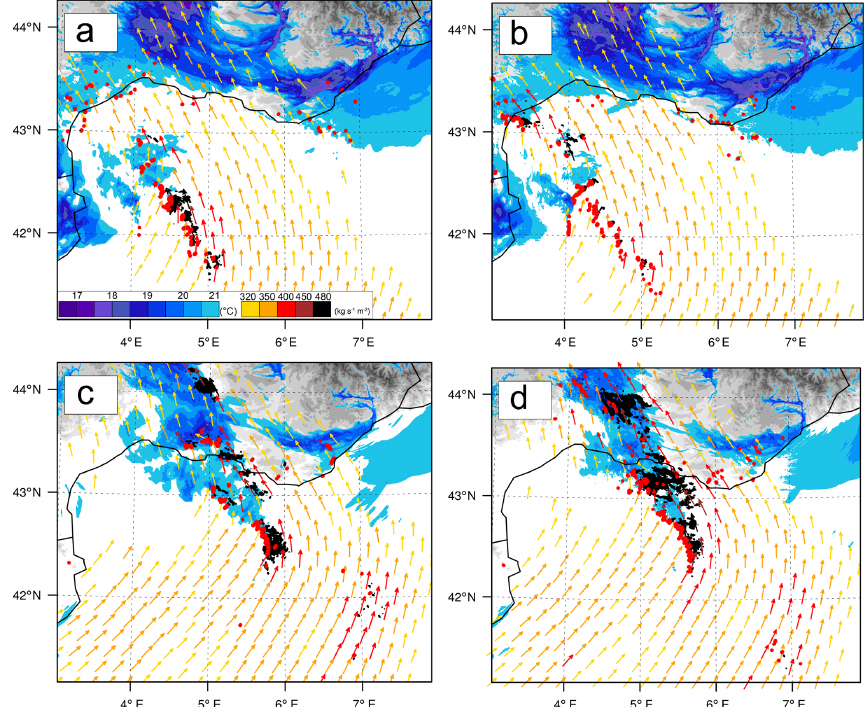
Figure 8. Same as Fig. 6 except for virtual potential temperature at the third model level (near 40ma.g.l.) ( ◦ C, blue areas), water vapour horizontal flux integrated over the lowest 3000ma.s.l. (kgm − 2 s − 1 , arrows), and vertical velocity exceeding 3ms − 1 at 500ma.s.l. (red isolines). Black areas denote values of moisture flux exceeding 480 kgm − 2 s − 1